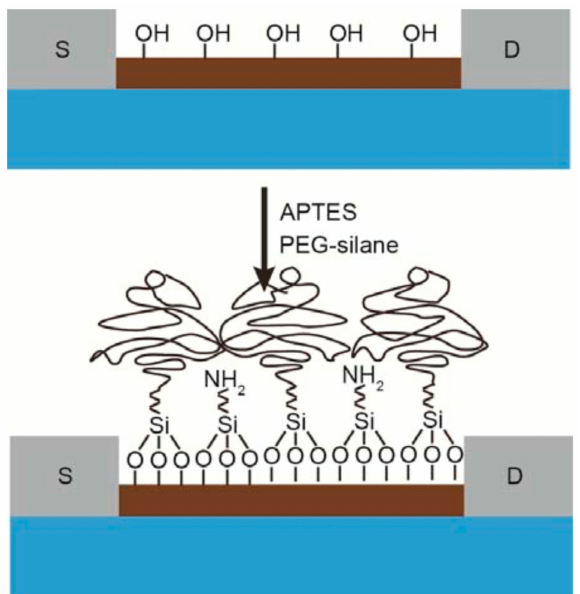
Figure 8. Surface modification of silicon nanowire surface with mixed-SAMs constituting of APTES and PEG-silane [109]. Reprinted with permission from Nano Letters, 15, Gao et al., General Strategy for Biodetection in High Ionic Strength Solutions Using Transistor-Based Nanoelectronic Sensors, 2143–2148. Copyright 2015 American Chemical Society.